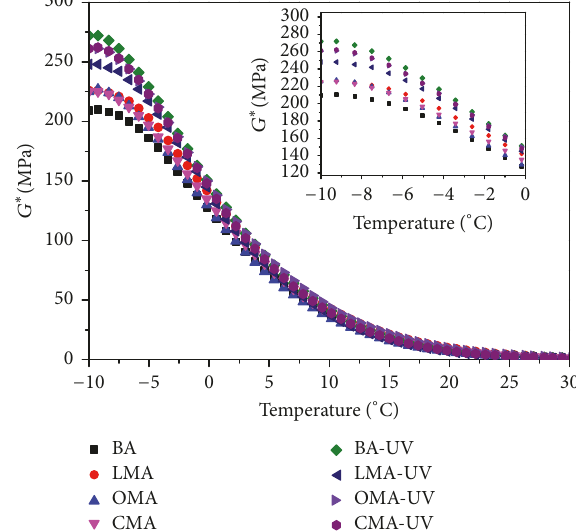
Figure 9: Stress of UV aged and unaged asphalt versus strain.